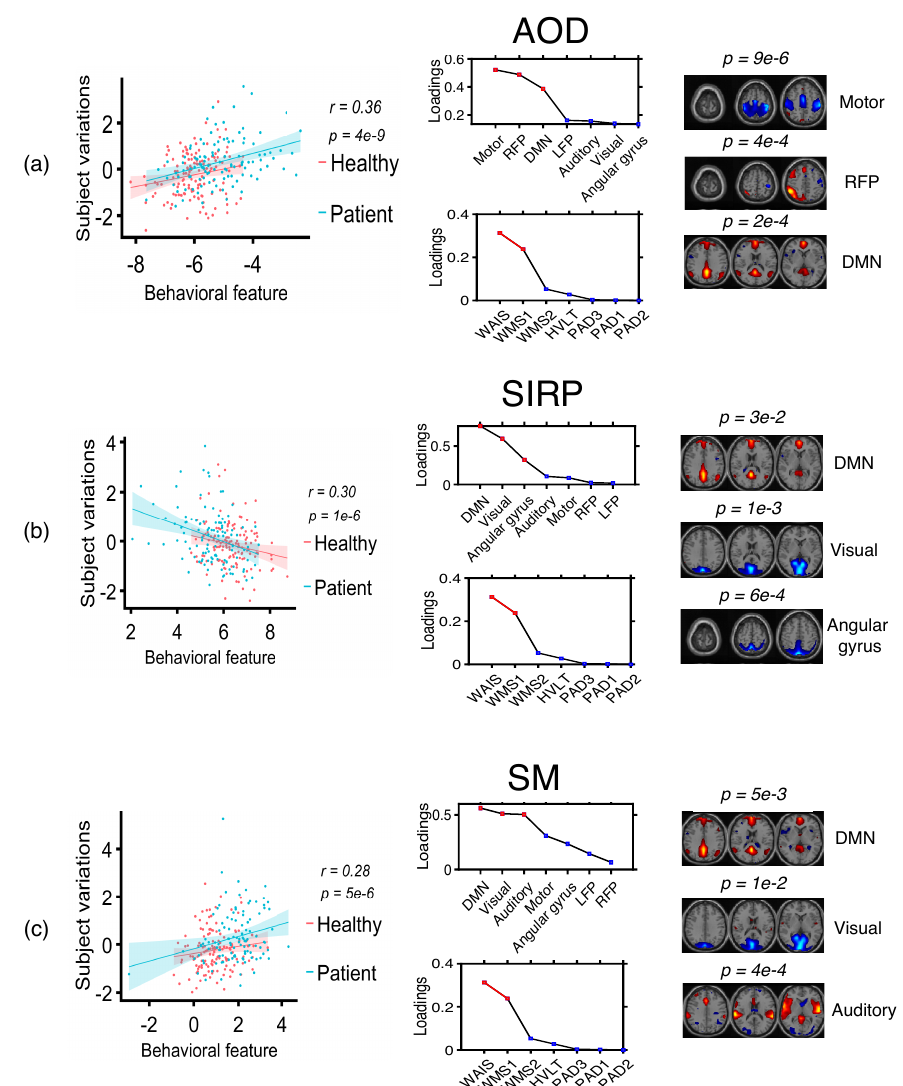
Figure 9. Behavioral features and subject profiles identified as correlated by IVA-G. Here, WAIS and WMS1 are correlated with the profiles associated to ( a ) motor cortex, RFP, and DMN components in AOD task; ( b ) DMN, visual cortex, and AG components in SIRP task; and ( c ) DMN, visual, and auditory cortex components in SM